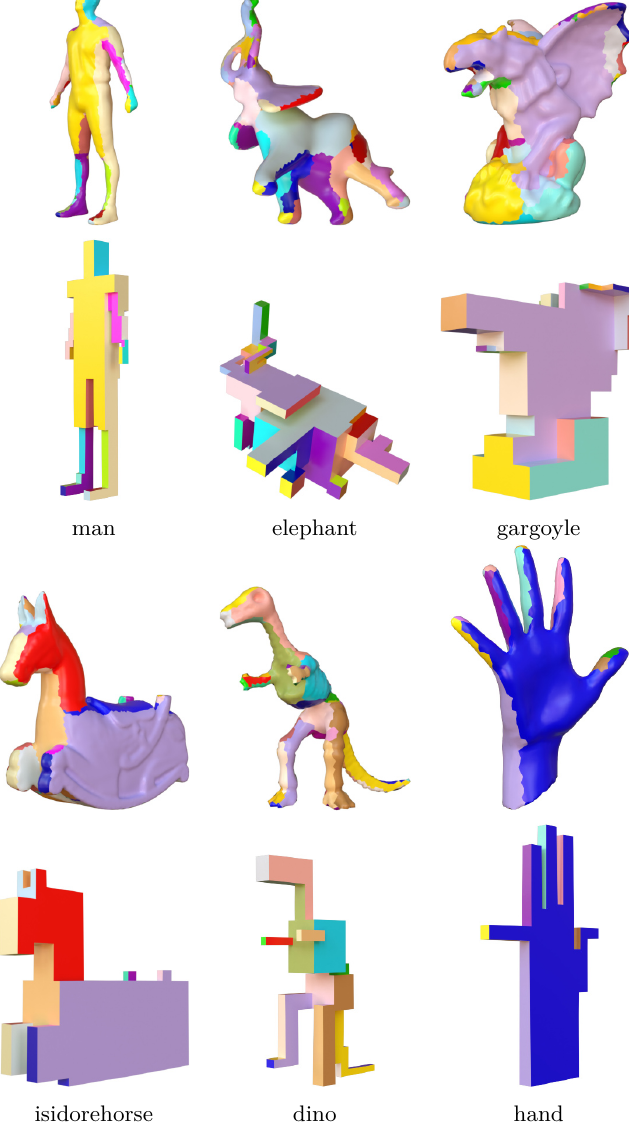
Fig. 5 Six models and their polycube shapes. model shapes.